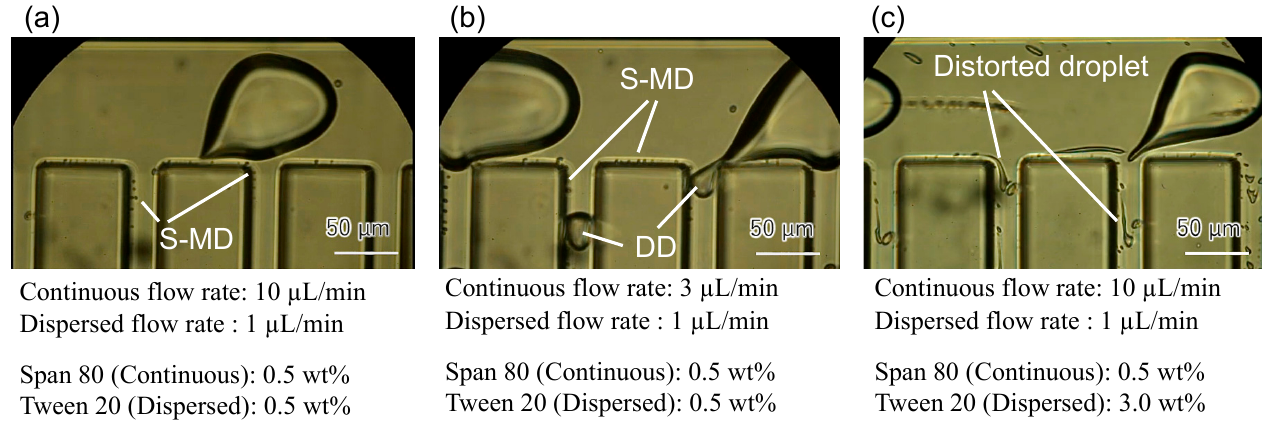
Figure 2. Generation of microdroplets under various conditions. ( a ): S-MDs are efficiently generated. ( b ): S-MDs and DDs are generated simultaneously. ( c ): The size and shape of S-MDs are not stable.